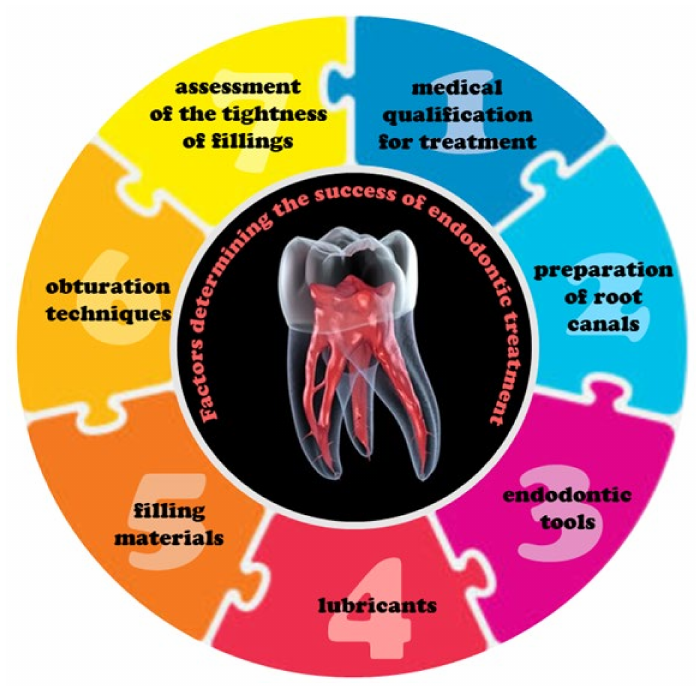
Figure 1. Scheme of the factors determining the success of endodontic